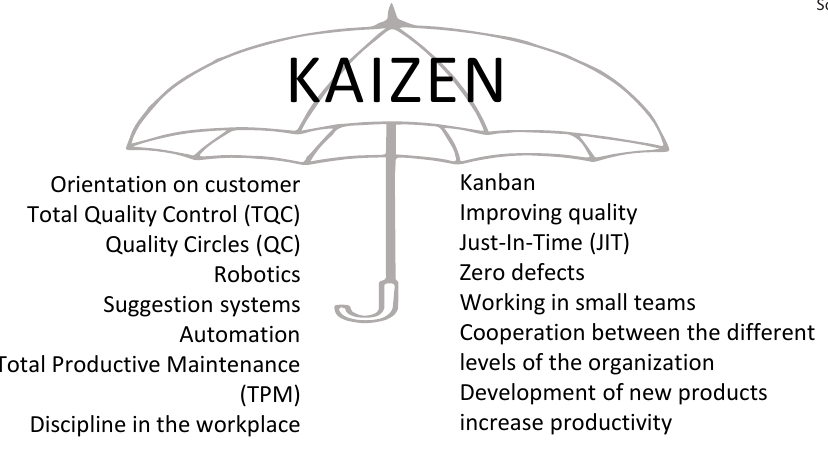
Figure 1. The Kaizen